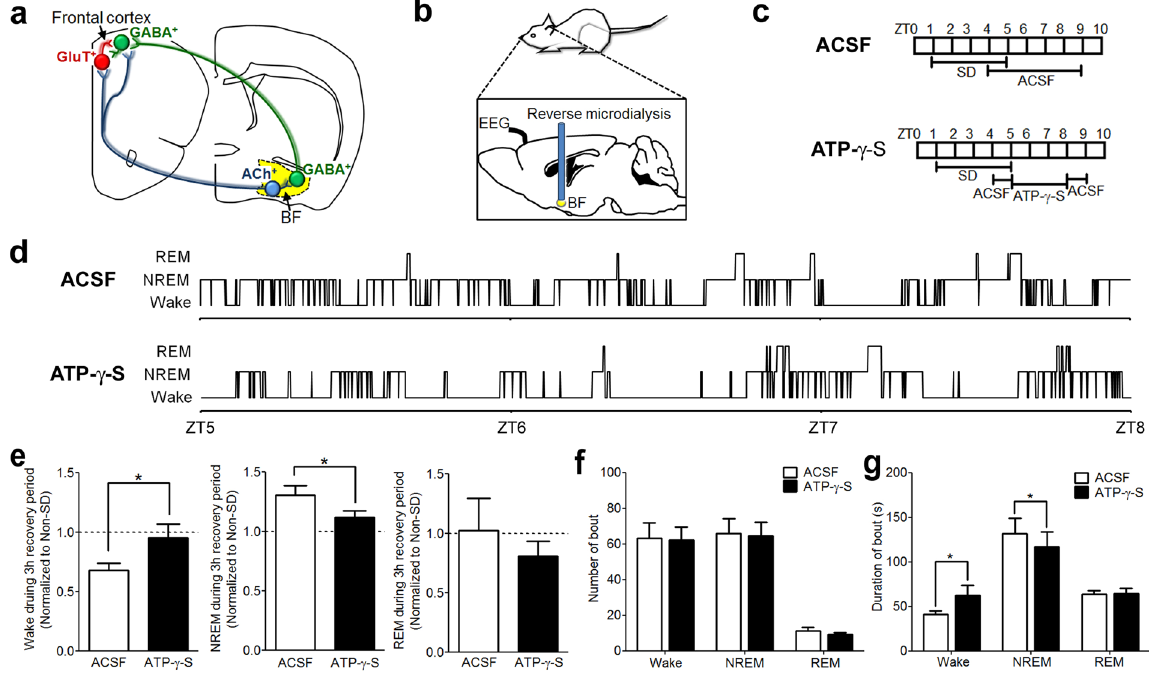
Figure 1. Infusion of a purinergic P2 receptor (P2R) agonist, ATP- γ -S, into the basal forebrain (BF) reduced the amount of rebound NREM sleep after sleep deprivation (SD). ( a ) Schematic showing the BF-cortex circuitry that controls cortical activation and sleep. BF cholinergic (ACh + ) neurons project to cortical glutamatergic (GluT + ) pyramidal neurons and cortical GABAergic (GABA + ) interneurons. ACh + neurons also excite cortically-projecting BF GABAergic (GABA + ) neurons which preferentially target the cortical interneurons responsible for the fast cortical activity typical of wakefulness. Frontal cortex: bregma 2.0 to 2.5 mm. BF: bregma − 0.10 to 0.02 mm 39 . (b ) Schematic showing the in vivo experimental set up for investigating the effects on sleep caused by pharmacological manipulating of mouse BF P2Rs. BF neurons were modulated by drug(s) infused via reverse microdialysis. Cortical activity/sleep was recorded with an EEG electrode implanted above the frontal cortex. Muscle tone was monitored using an EMG electrode implanted in the neck muscle. (c ) Experimental protocol to test the effect of ATP- γ -S on sleep homeostasis. Mice were sleep deprived from Zeitgeber time (ZT)1-5. ATP- γ -S (1 mM in infusion solution, which results in ~100 µ M within the tissue) or artificial cerebrospinal fluid (ACSF) was infused during the 3-h recovery sleep period (ZT5–8). (d ) Hypnogram from one representative mouse showing the sleep-wake states during the recovery periods following SD. (e ) Changes of time spent in wakefulness, NREM sleep and REM sleep during the 3 hr recovery period. SD induced a rebound increase in NREM sleep and a concomitant decrease in wakefulness. ATP- γ -S infusion during the recovery period reversed these effects, increasing wakefulness and decreasing NREM sleep. n = 9. Data were normalized to the sleep/wake amount at the same time of day without any sleep deprivation (non-SD). ( f and g ) Increased wakefulness during the 3 h recovery period following SD in the presence of ATP- γ -S was due to longer wake bouts. The number of bouts was unchanged. (e – g ) Paired-t-test. * p <